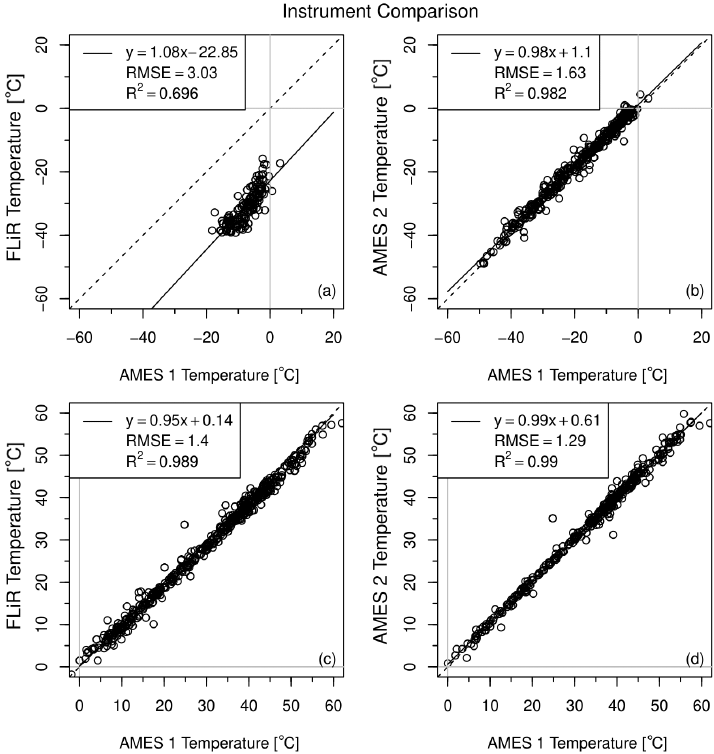
Figure 1. Comparisons between the AMES 1, the FLIR i3 ( a, c ), and the AMES 2 ( b, d ) for clear sky ( a, b ) and ground ( c, d ). A 1 : 1 line is indicated as a dashed black line, with the linear least-squares fit represented as a solid black line.